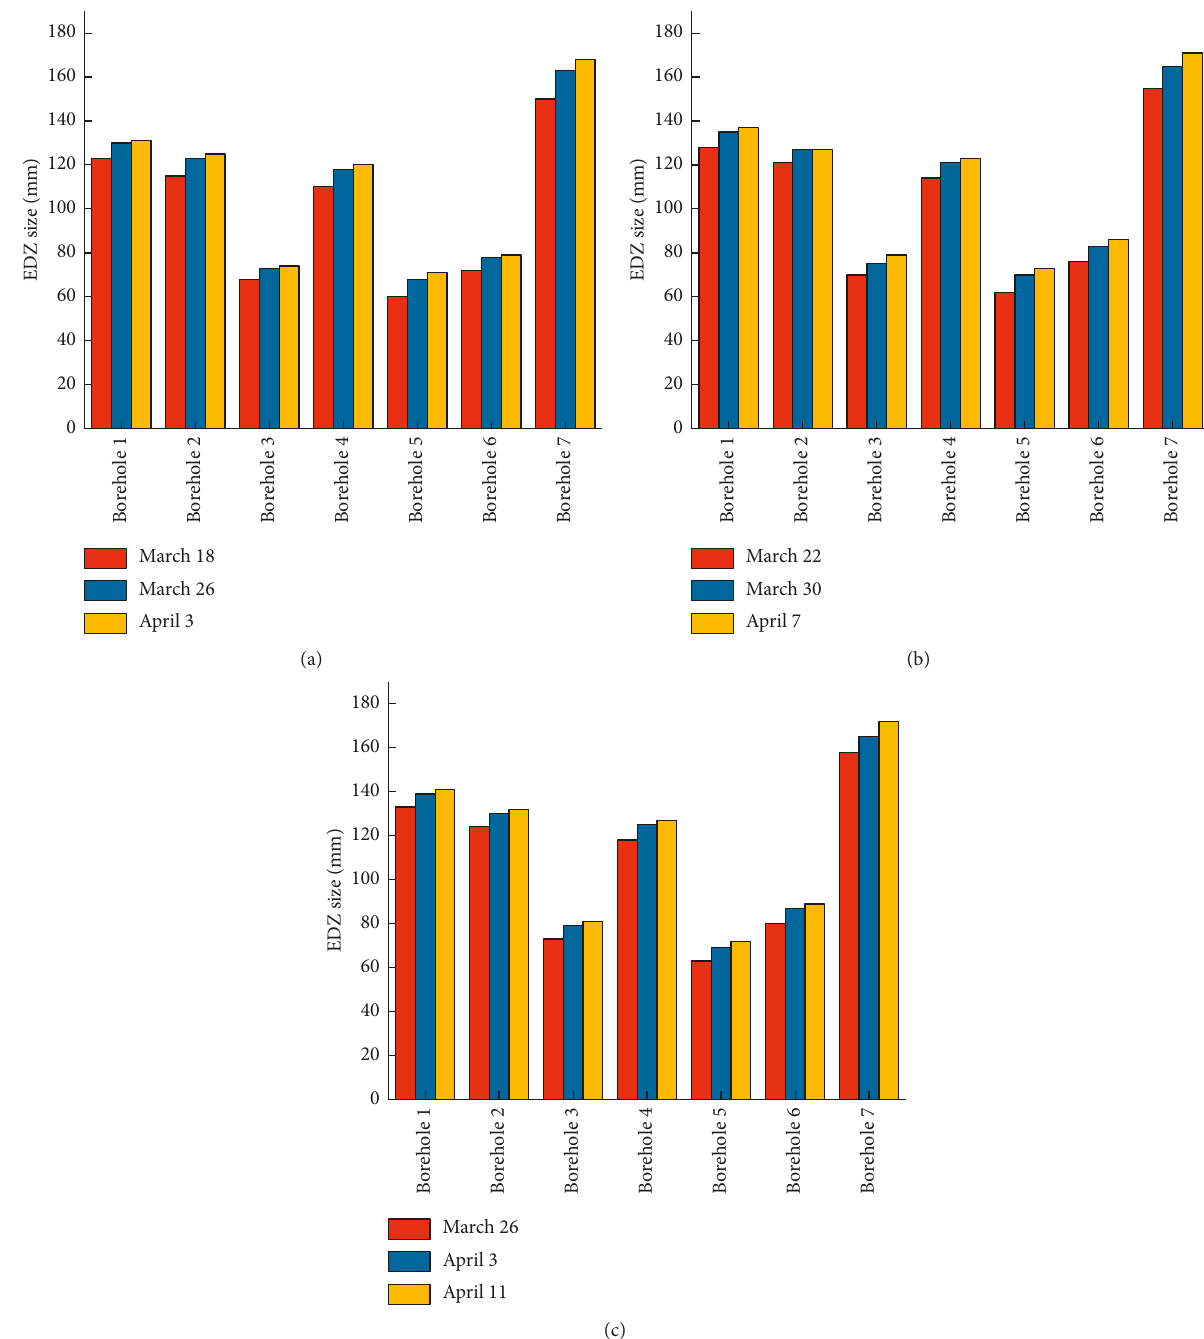
Figure 8: Time development laws for EDZ